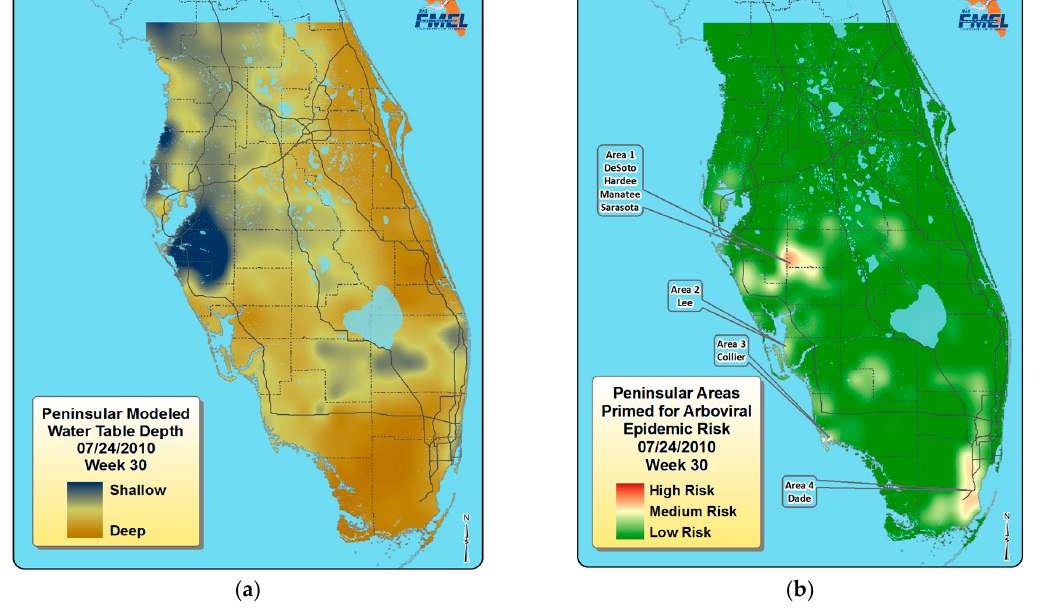
Figure 4. ( a ) A hydrological map for south Florida showing the ground water table during a one-week period in 2010. ( b ) A risk map for West Nile in Florida based on this hydrological information, models, and knowledge about reservoirs, vectors, and virus amplification and high-risk regions for WNV transmission (Courtesy of Jonathan F. Day).